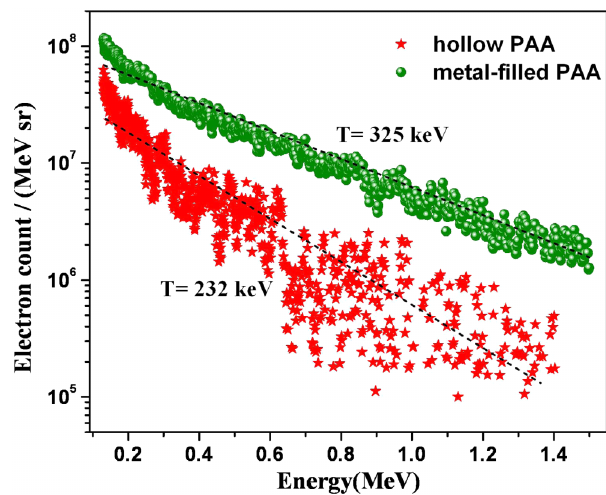
FIG. 6. Rear side hot electron measurement for hollow and metal-filled PAA targets.